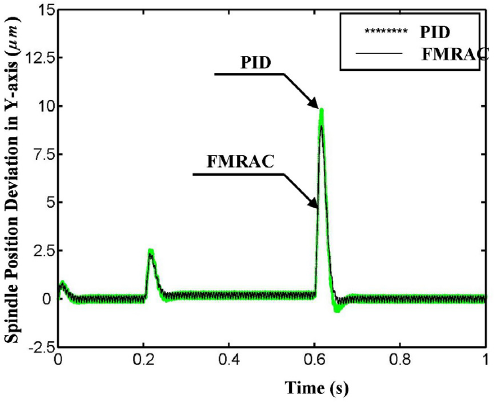
Figure 14. Spindle position deviation in the Y -axis under various control laws.